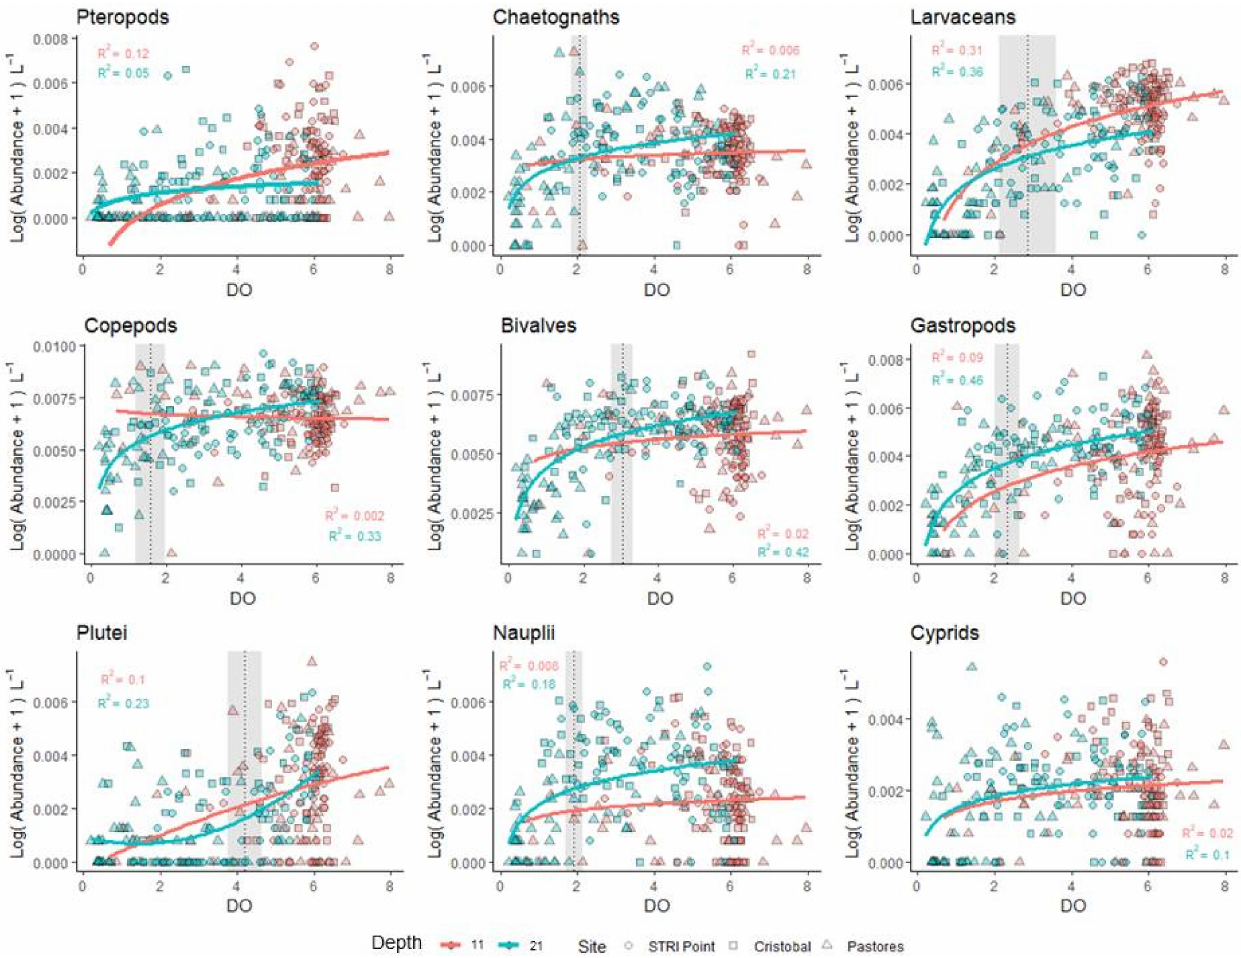
Figure 10. Relationships between oxygen concentration (DO, mg L − 1 ) and order-of-magnitude concentration of the nine groups of zooplankton. Trendlines lines show the best fit for the abundances at each depth (red for 11 m and blue for 21 m), assuming concentration ~log(DO) for all groups except plutei at 21 m, which assumes concentration ~(DO) 2 . Vertical dotted lines denote ‘breakpoints’ ( ± SE; grey rectangles) for taxa at 21 m, as identified in piecewise linear regression (Figure S1) and shown only for models with R 2 > 0.25. Point shape denotes